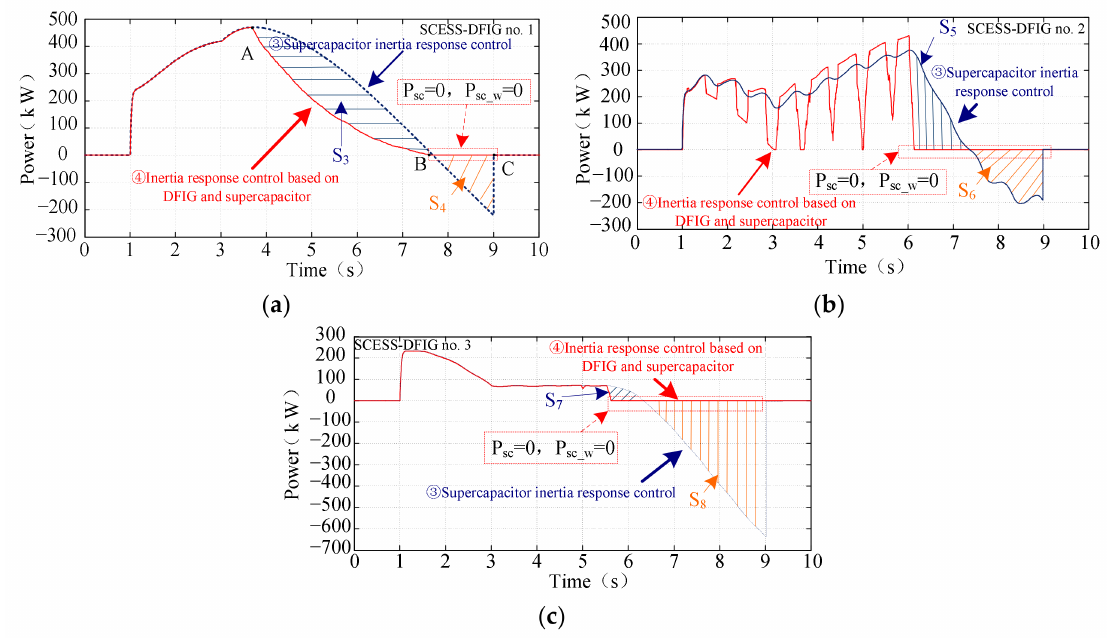
Figure 20. Comparison of output power of supercapacitor energy storage device under different control strategies: ( a ) The supercapacitor energy storage device output power under different control strategies for no. 1 SCESS-DFIG; ( b ) The supercapacitor energy storage device output power under different control strategies for no. 2 SCESS-DFIG; ( c ) The supercapacitor energy storage device output power under different control strategies for no. 3